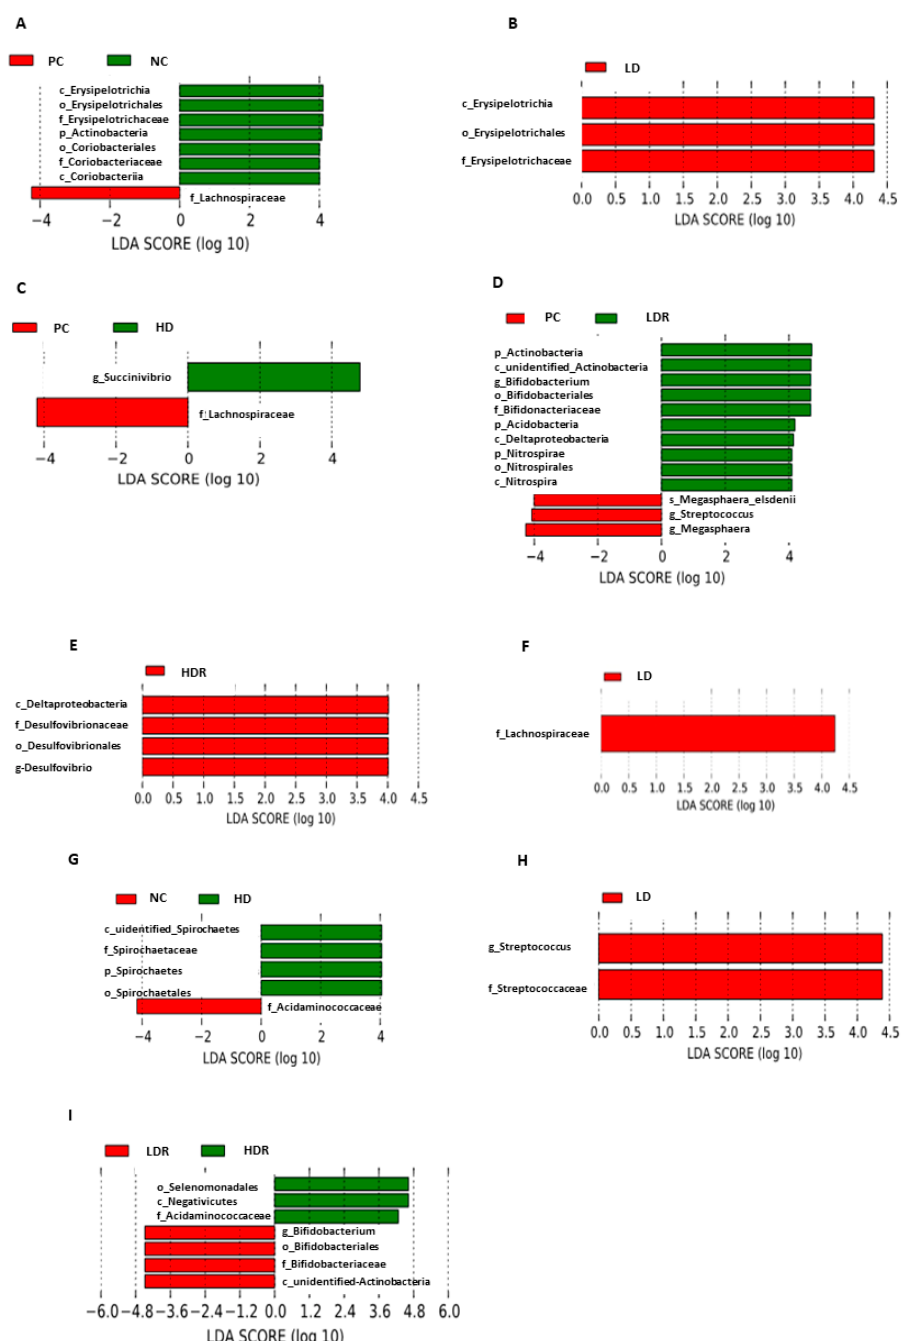
Figure 5. Fecal microbiota composition histograms in pigs fed with low-protein diets supplemented with a corn-expressed phytase. Histograms of linear discriminant analysis (LDA) with e ff ect size (LEfSe) on fecal microbiota composition ( A ) PC vs. NC, ( B ) PC vs. LD, ( C ) PC vs. HD, ( D ) PC vs. LDR, ( E ) PC vs. HDR, ( F ) NC vs. LD, ( G ) NC vs. HD, ( H ) LD vs. LDR, ( I ) LDR vs. HDR. Pigs are grouped based on their dietary treatments: PC (positive control): normal protein, adequate Ca and available phosphorous (aP), no corn-expressed phytase (CEP) added; NC (negative control): low protein, adequate Ca and aP, no CEP added; LD: NC + CEP added at low dose, i.e., 2000 FTU / kg of diet; HD: NC + CEP added at high dose, i.e., 4000 FTU / kg of diet; LDR: LD with reduced calcium (Ca) and phosphorus (P); HDR: HD with reduced Ca and P. There was no significant di ff erence on species identified for LD vs. HD and HD vs. HDR. n = 6 for each dietary